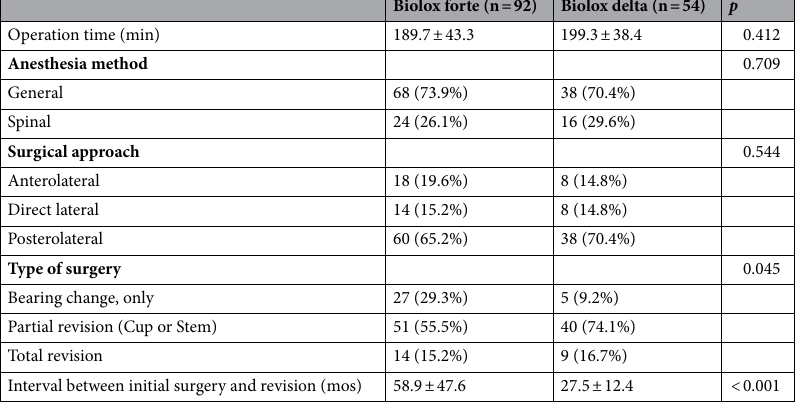
Table 2. Characteristics of